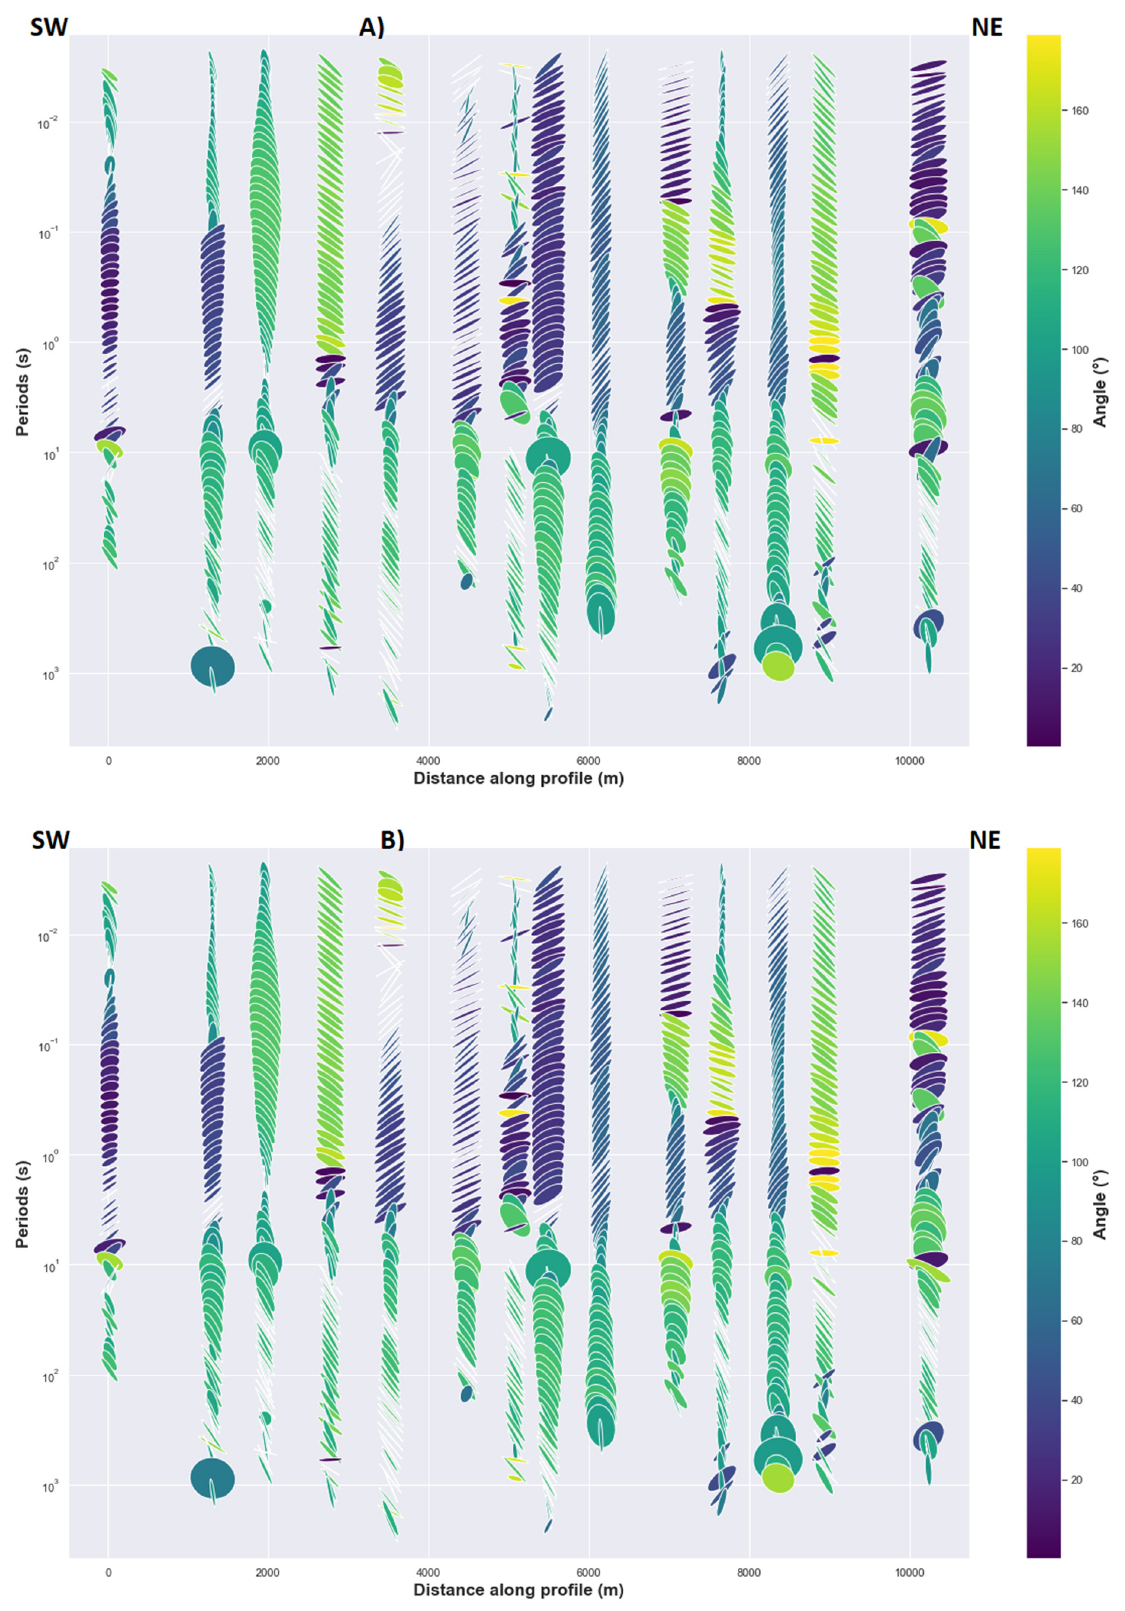
Figure 4. ( A ) Strike angle from impedance invariants and ( B ) strike angle from decomposition model. The major and minor axes of ellipse, respectively, correspond to the Φ max and Φ min of phase tensor. Each ellipse is in map view, so up is North and to the right is East.